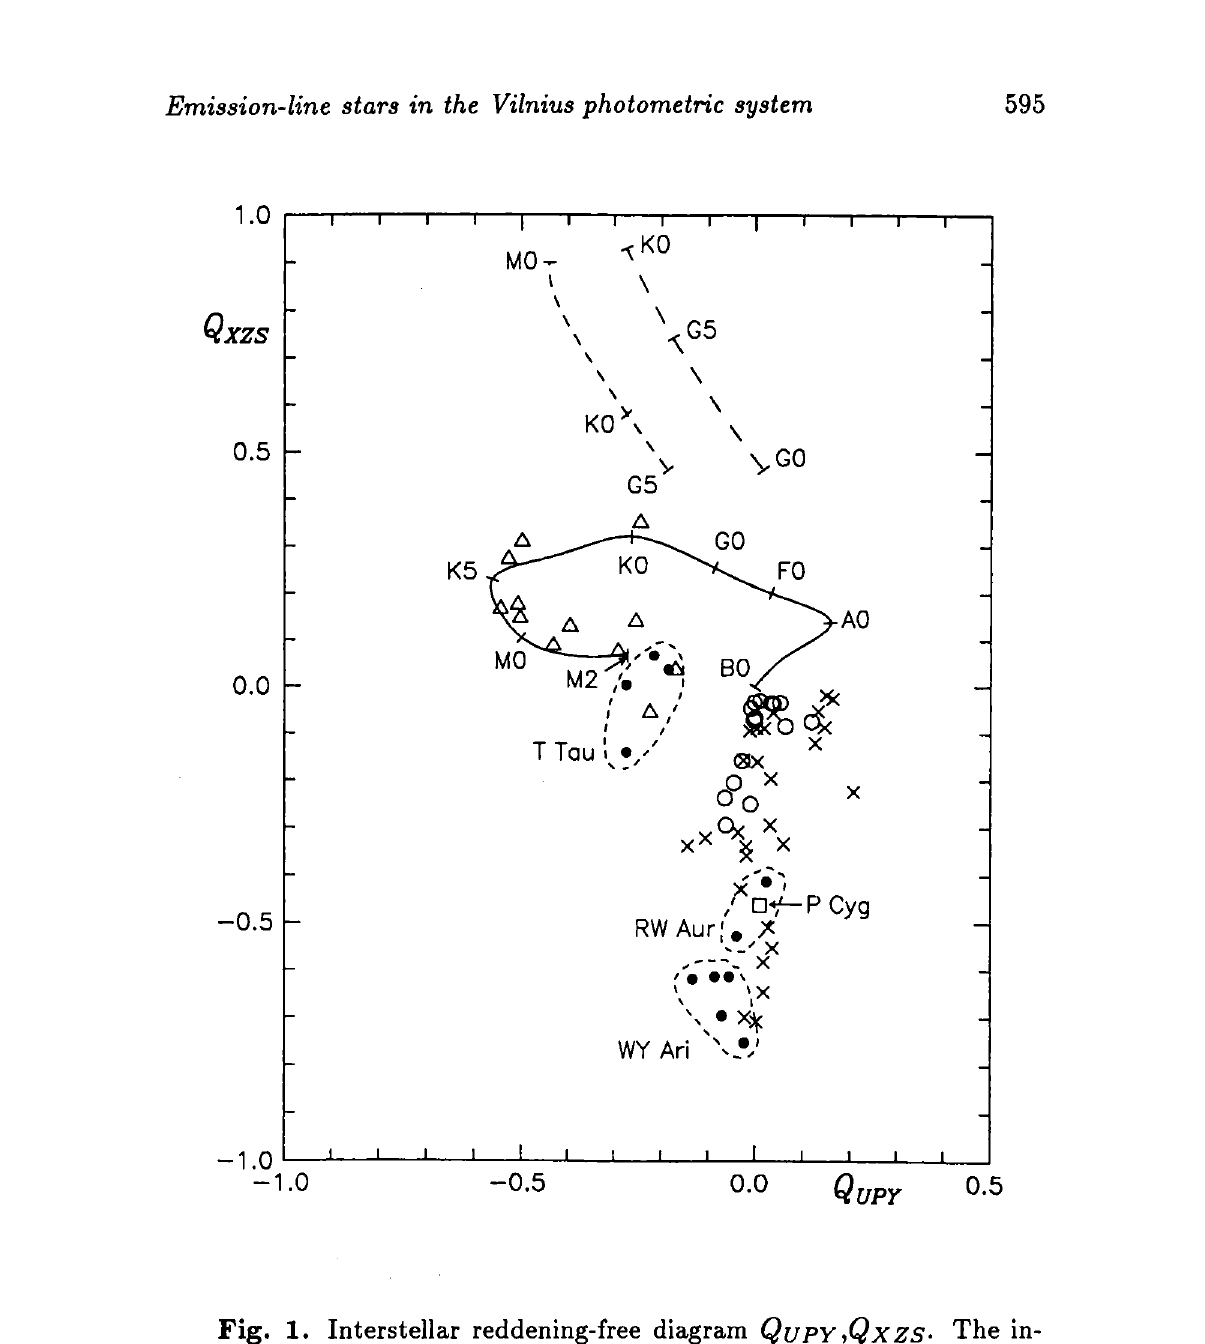
Fig. 1. Interstellar reddening-free diagram QuPY >Qxzs· The in- trinsic lines of stars of normal chemical composition are shown: the solid line is for main-sequence stars, the short-dashed line is for giants and the long-dashed line is for supergiants. Open circles are for Be stars, X signs are for Herbig Ae/Be stars, dots are for Τ Tauri-type stars (circled by dashed curves) and triangles are for K-M dwarfs with active chromo-